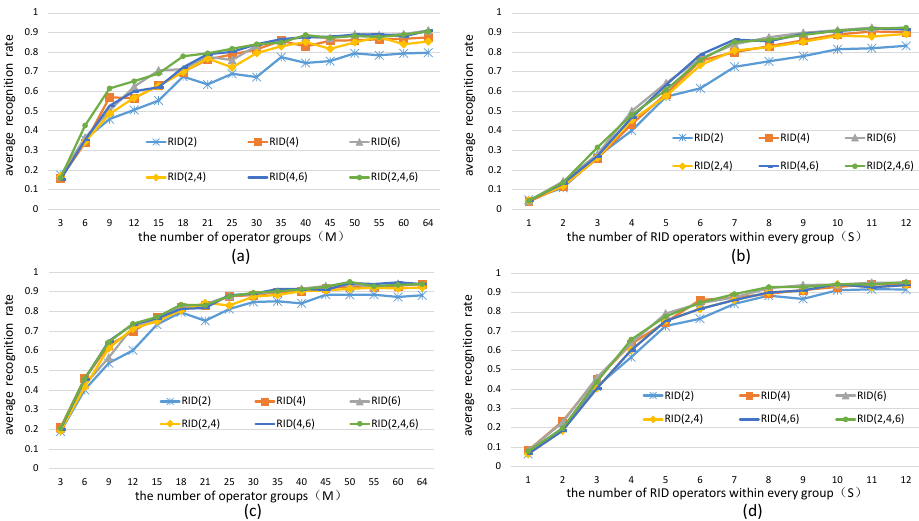
Figure 6. Average recognition rate curves of RandomFerns classifier embedded with different kinds of RID operators across all images in Figure 4a. The experiments in ( a , c ) are made by keeping S = 8 while increasing parameter M ; the experiments in ( b , d ) are made by keeping M = 40 while increasing parameter S . The results in ( a , b ) are obtained from gray imags; ( c , d ) from color